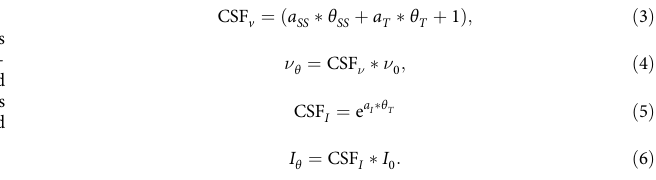
Section 3: Unit cell setup . For nanoparticle calculations, the vacuum space was 20Å between periodic images in the unit cell axes directions. For slab calculations, the vacuum space between periodic images in the surface normal direction was set to 20 Å. Image dipole corrections did not signi fi cantly alter frequency and intensity calculations for CO adsorbed on the nanoparticles but can slow convergence of the wave function so were left out. These corrections were applied to the energy, forces, and potential in the surface normal direction only for calculations involving extended surfaces. Dipole corrections were included for all calculations involving NO, including nanoparticles. The slabs used in parameterizing the high coverage GCN pdf model were 8 atoms thick. Slabs used to identify the lateral interactions for CO were 4 atoms thick. The number atoms in each layer varied depending on the speci fi c coverage and overlayer pattern. The number of k-points in directions perpendicular to the surface normal times the width of the unit cell in the relevant direction was at least 30Å to maintain accuracy of the forces and dipoles. The k-point mesh was therefore set to 12/n ×12/m ×1 where n and m were the number of Pt slab atoms in the x and y direction, respectively. For all slab calculations, the top two layers were relaxed and the remaining bottom layers were fi xed with a 3.935 Å lattice constant to simulate the bulk, determined using a 15 × 15× 15k-point grid using the tetrahedron method with Blöchl corrections combined with the Birch – Murnaghan equation of state 57 . All input fi les were created using the atomistic simulation environment (ASE). Section 4: Adsorption sites and fi rst-principles data . We study adsorption of CO at the three and fourfold hollow, bridge, and atop sites on nanoparticles ranging from 3 to 201 atoms. The sampled nanoparticles include icosahedrons and octahedrons as well as structures built using Wulff construction based on the experimental Pt surface energy for the (111) low-index plane 58 and the atomic corrugation factors 59 for the (100) and (110) low-index planes. Our dataset of nanoparticles also includes defected structures, fully and partially relaxed struc- tures, as well as some systems with spin-polarized calculations. The combination of different types of structures, for which we ultimately obtain frequencies and intensities, facilitates modeling of real systems in which particle shape often diverges from the thermodynamic equilibrium. In total, we consider 1008 unique nanoparticle-adsorption systems with a single adsorbed-CO. Defected Pt nano- particles are generated by removing Pt atoms in perfect icosahedron, octahedron, or Wulff constructed nanoparticles. Up to three atoms furthest from the chemi- sorbed CO were removed in order to reuse the equilibrated structure. Partial relaxation was performed by stopping a relaxation for nanoparticles with adsorbed CO before all forces on the Pt atoms were below 0.05eV/Å. To incorporate high coverage ordered overlayers into the GCN pdf model, fi rst- principles data also includes the (111), (100), and (110) extended surfaces of Pt with adsorbed CO overlayers that correspond to the highest coverage pattern determined experimentally by LEED. For these facets, the highest coverage overlayers are the c(4 ×2) 2 , c(4 × 2) 41 , and p(2× 1) 60 con fi gurations, respectively, that correspond coverages of 0.5, 0.75, and 1 ML, as discussed extensively in literature 44 . Section 5: Identifying the binding and describing structure . We determine the binding according to the number of platinum atoms the carbon atom in the adsorbed carbon monoxide is connected to using a cutoff radius of 1.25 (unitless) times the van der Walls distance between atoms (Å). First, we calculate the distance between every platinum nucleus and the carbon nucleus. If the distance between the platinum and carbon atom is less than the cutoff radius times the sum of the platinum and carbon van der Walls radii (1.36 Å and 0.76 Å, respectively), we consider the two atoms to be connected. The total number of platinum atoms connected to the carbon (1, 2, 3 or 4) corresponds to classi fi cation as an atop, bridge, threefold, or fourfold site. This same procedure (distance) used in identifying the platinum atoms connected to the carbon (binding-type) is repeated with the Pt atoms connected to the adsorption-site Pt atoms (the fi rst nearest neighbors) to generate a site coordination. In this case, the cutoff used was 1.25 times the van der Walls diameter of a Pt atom. We use the method of Calle-Vallejo et al. 26 to calculate the GCN, which takes into account also second nearest-neighbor Pt atoms. We use the combination of binding-type and GCN to characterize adsorption microstructure. We fi nd that the complete set of GCNs for our data is somewhat dependent on the cutoff radius with cutoff radii of 1.2, 1.25, and 1.3 all generating slightly different GCN sets. While this fact does not alter the results or their signi fi cance, alternative methods to distinguish connectivity between atoms, such as Voronoi tessellations 61 or other space fi lling methods, are worth exploring in future research. Section 6: Calculating frequencies and intensities . Frequencies corresponding to transitions from the ground to fi rst vibrational state were calculated using mass weighted normal mode analysis 62 under the harmonic approximation. VASP cal- culations provided the forces and we used these forces to construct mass weighted Hessians. Eigen decomposition was applied to the Hessians to extract eigenvalues (frequencies) and eigenvectors (directions of the vibrations). Forces on carbon and oxygen were calculated upon 0.025Å displacements from their equilibrium posi- tions in the x, y, and z directions. The chosen perturbation has previously